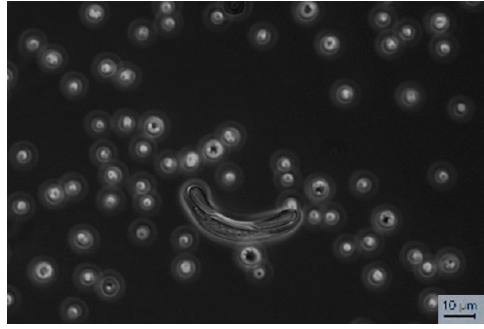
Figure 3. Spathaspora passalidarum budding cells with characteristic curved and elongated ascospore.